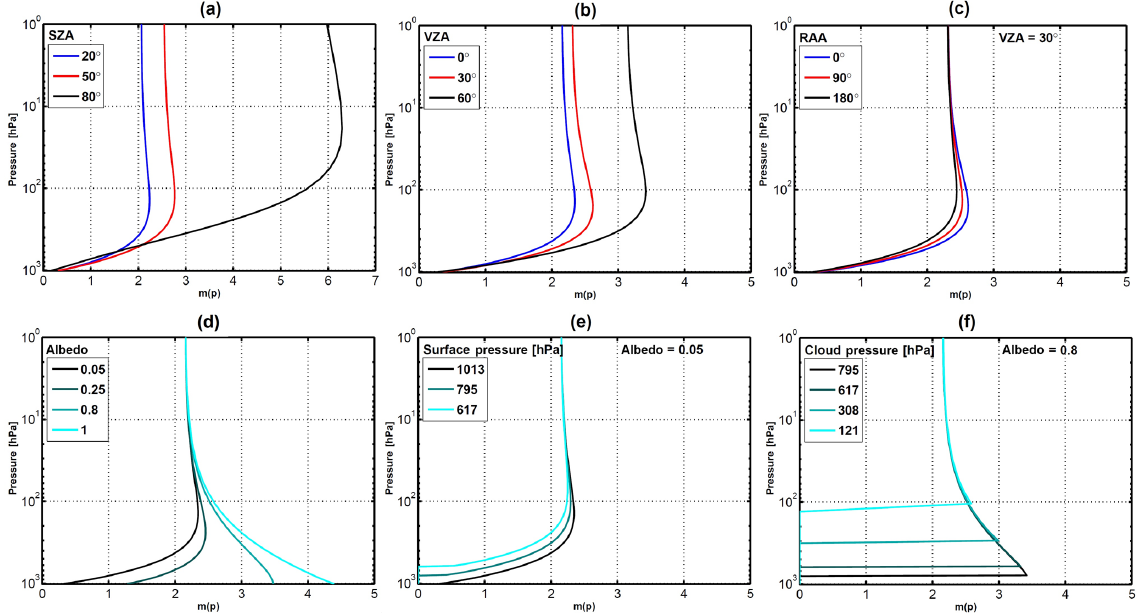
Figure 6. Variation of the altitude-dependent air mass factor with (a) solar zenith angle, (b) viewing zenith angle, (c) relative azimuth angle between the sun and the satellite, (d) surface albedo, (e) surface pressure for a weakly reflecting surface, and (f) surface pressure for a highly reflecting surface. Unless specified, the parameters chosen for the radiative transfer simulations are a solar zenith angle (SZA) of 30 ◦ , a viewing azimuth angle (VZA) of 0 ◦ , a relative azimuth angle (RAA) of 0 ◦ , albedo of 0.05, surface pressure of 1063hPa, and λ =